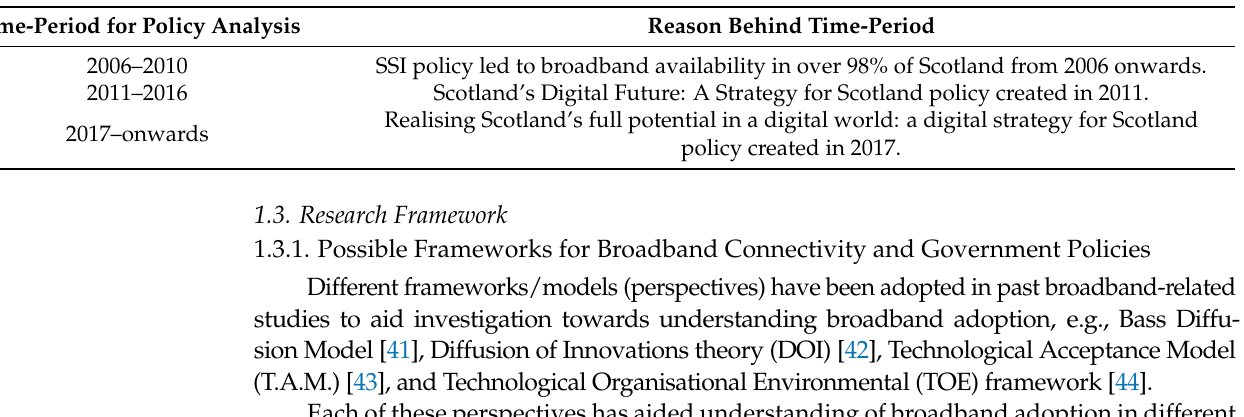
Table 1. Policies periods and their rationale.